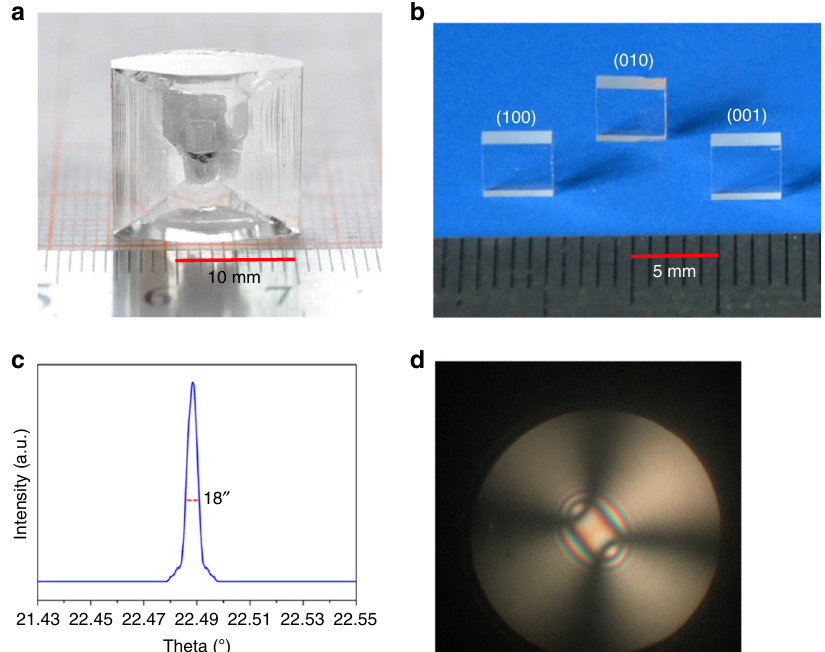
Fig. 3 The as-grown single crystal and optical quality experiments of Pna 2 1 -Ba 3 Mg 3 (BO 3 ) 3 F 3 . a Photograph of the as-grown crystal with dimensions up to 16 × 14 × 8 mm 3 grown by the top-seeded solution growth method. b The cut and polished (100), (010), and (001) wafers with dimensions up to 4 × 4 × 1 mm 3 . The crystals were cut plane parallel and polished to optical quality using a Unipol-300 grinding/polishing machine. c The high-resolution X-ray diffraction rocking curve for (100) wafer. The full-width at half-maximum on (100) face of the Pna 2 1 -Ba 3 Mg 3 (BO 3 ) 3 F 3 crystal is about 18 ″ , indicating high crystalline quality. d The conoscopic interference pattern of Pna 2 1 -Ba 3 Mg 3 (BO 3 ) 3 F 3 crystal. All the images and elements of them were created by